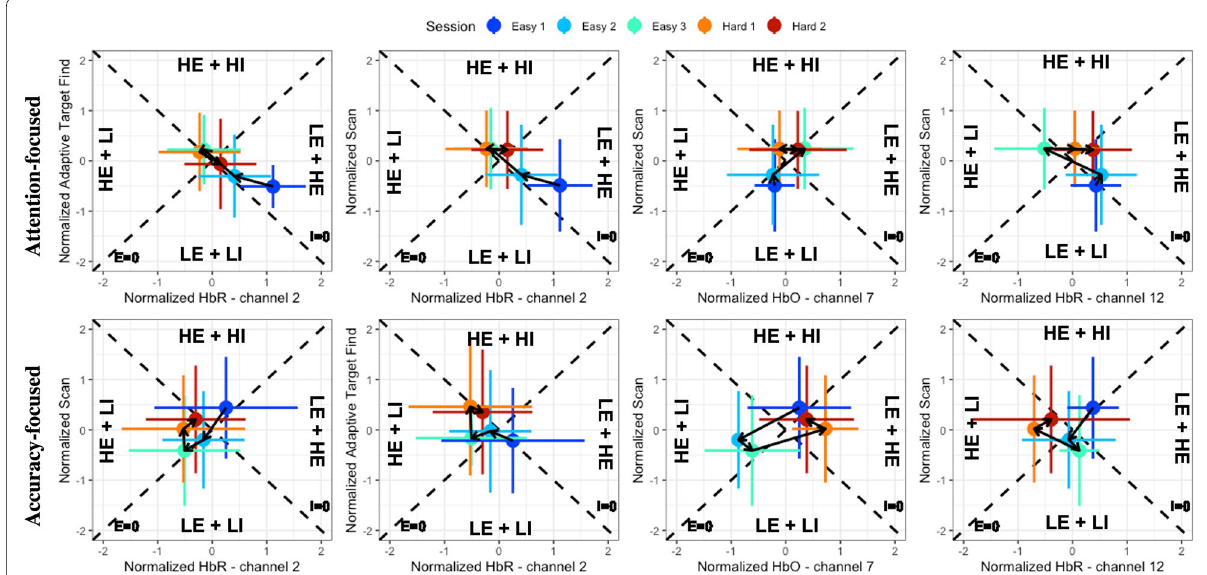
Fig. 6 Changes in efficiency and involvement based on adaptive target find and scan performance and fNIRS measures from channels 2, 7, and 12 per Group and Session. The four quadrants generated by the efficiency ( E ) (HE) or low efficiency (LE) and high involvement (HI) or low involvement (LI). Circles on the graphs reflect mean, while error bars represent standard